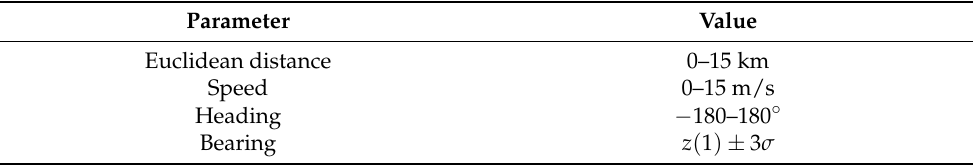
Table 2. Search range of the state